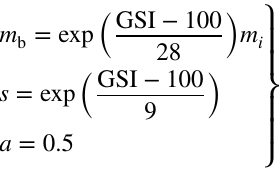
Fig. 8 GSI-Strength degradation model fitting